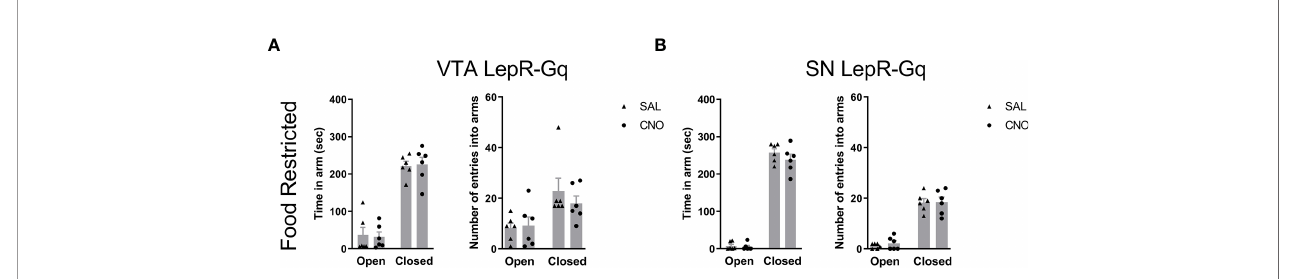
FIGURE 9 | Anxiety-like behavior upon chemogenetic activation of VTA LepR or SN LepR neurons. Anxiety-like behavior in the EPM was not affected by CNO (1.0mg/kg) VTA LepR-Gq (n=6) (A) and SN LepR-Gq (n=6) (B)